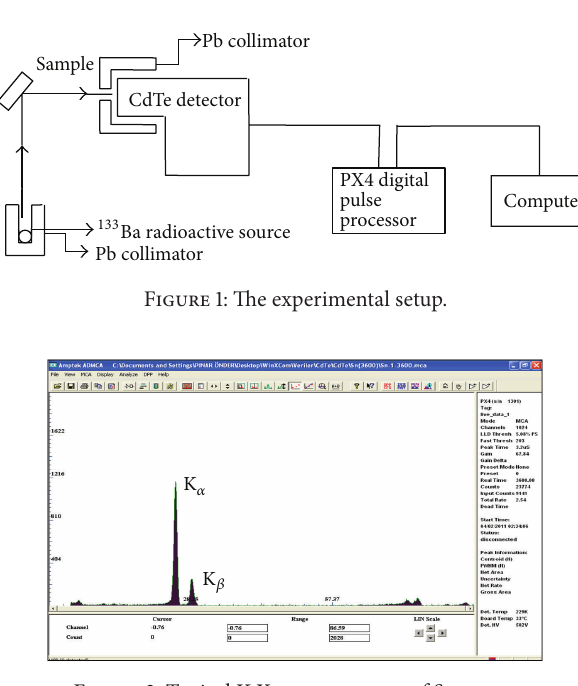
Figure 2: Typical K X-rays spectrum of Sn